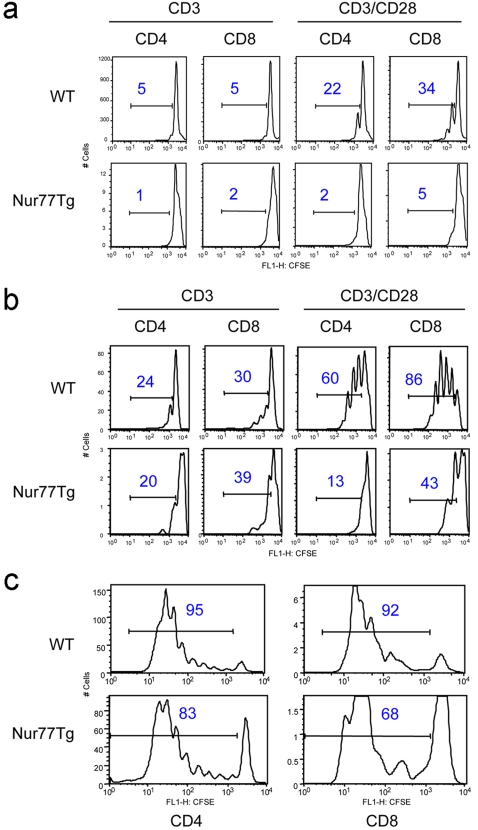
Impaired proliferation of Nur77Tg T cells.(a) Impaired T cell proliferation of CFSE-labeled Nur77Tg mice after 48 h of in vitro activation with soluble CD3 mAb alone or plus CD28 mAb; figure in each square indicates percentage of the gated population. (b) Assessment of T cell proliferation after 72 h; experimental details as for previous panel. (c) Impaired proliferation of Nur77Tg T cells after allo-stimulation in vivo. Allogeneic T cell responses were generated by i.v. injection of CFSE-labeled B6 or Nur77Tg spleen and lymph node cells into B6/DBA F1 recipients. !After 72 h, donor derived allo-reactive T cells were identified by gating on H-2Kd (-) and H-2Dd (-) cells and T cell proliferation assessed by CFSE division profiles; note different y-axis for WT vs. Nur77Tg T cells. Figure in each square indicates percentage of the gated population; data representative of 3 experiments with similar results.